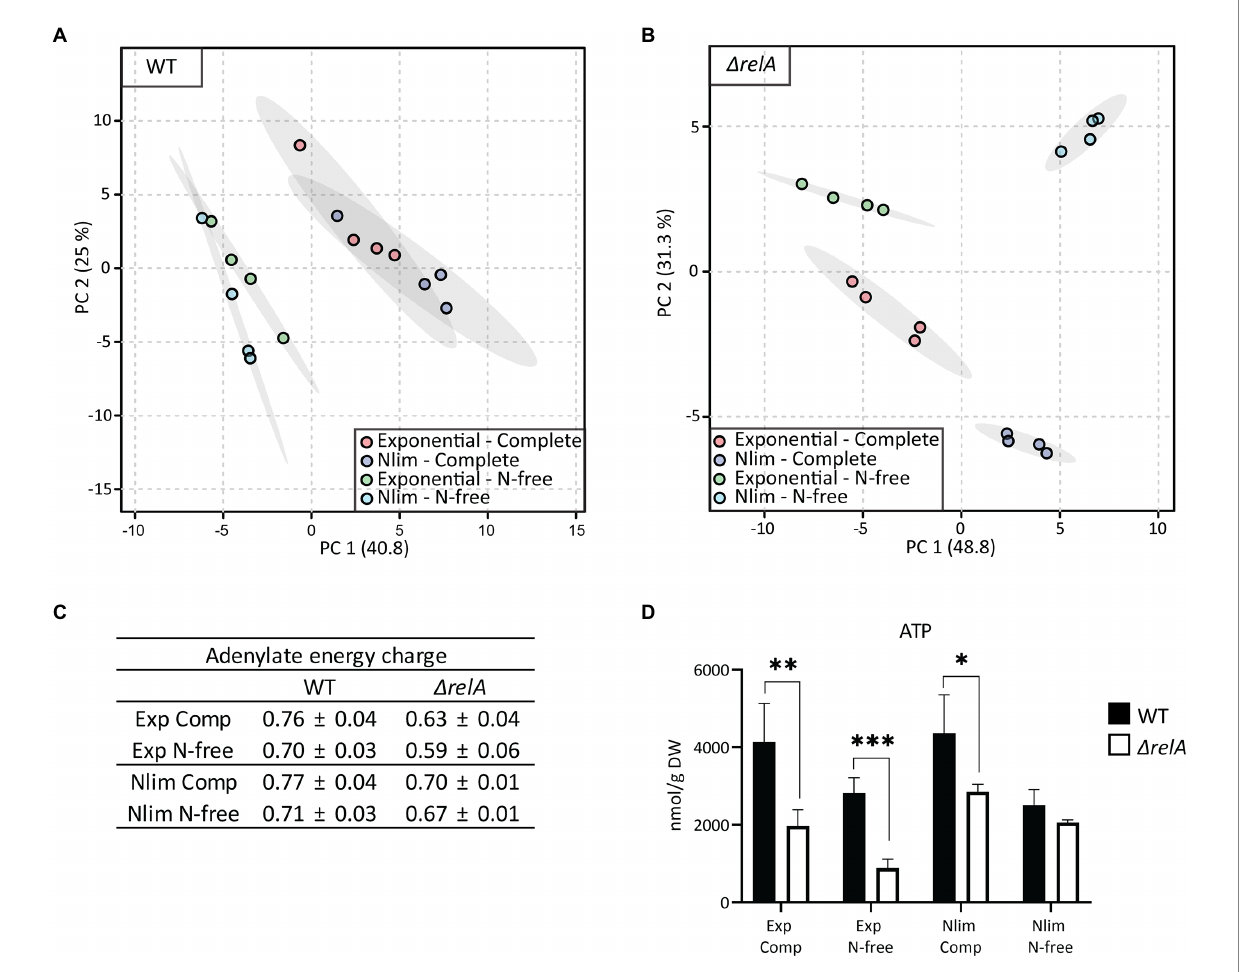
FIGURE 5 Metabolite profiling of E. coli WT and Δ relA from two pregrown states resuspended into complete or N-free media. Aliquots from either exponential phase or nitrogen-limited stationary phase were resuspended in either complete or N-free media, and samples were taken for metabolic analysis immediately after resuspension. Principal component analysis (PCA) with 57 metabolites was performed for (A) WT and (B) Δ relA samples. (C) Adenylate energy charge (AEC) was calculated using the absolute concentrations of ATP, ADP, and AMP, with n = 4. (D) Absolute ATP concentrations, with unpaired, two-tailed t-test between each condition, n = 4. * p ≤ 0.05, ** p ≤ 0.01, *** p ≤ 0.001. Comp, Complete HAS-medium; N-free, HAS medium lacking nitrogen; Exp, exponential phase; Nlim, nitrogen-limited stationary